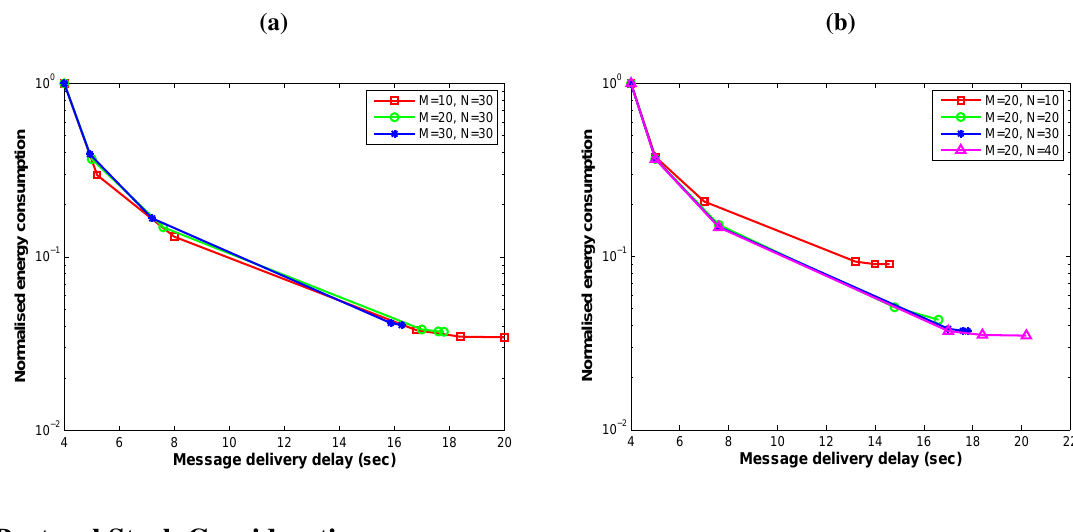
Figure 5. Optimal operating points for the network model under investigation. (a) Energy efficiency gains for increasing number of active users within the cell; (b) Energy efficiency gains for increasing number of candidate forwarding